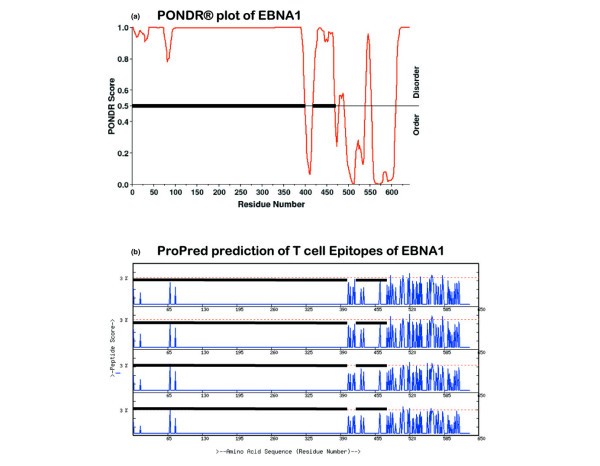
Disorder and T cell epitope prediction for EBV Nuclear Antigen 1. (a) PONDR® plot of the Epstein Barr Nuclear Antigen 1 protein (Swiss-Prot: P03211). The PPPGRPP epitope that induces cross-reactivity to an epitope on Sm B/B' is found in residues 398–412, almost exactly at the sharp minimum of the PONDR® plot. This is the only known cross-reacting epitope in the virus. (b) T cell epitopes of EBNA1 predicted by the ProPred server. Only the results for alleles HLA-DRB_01, HLA-DRB_0102, HLA-DRB1_0301, and HLA-DRB_0305 are shown. The remaining 47 alleles show a very similar picture. The threshold is set at 3%. The black bars delimit the strongly disordered regions of the PONDR® plot shown in (a). It is apparent that the highly disordered region of the first approximately 400 amino acids is predicted to be nearly devoid of potential T cell epitopes. The epitope from residues 398–412 that cross-reacts with the SmB protein is predicted to be most reactive with alleles HLA DRB5_0101 and DRB5_0105, although just slightly below a 3% threshold (data not shown).